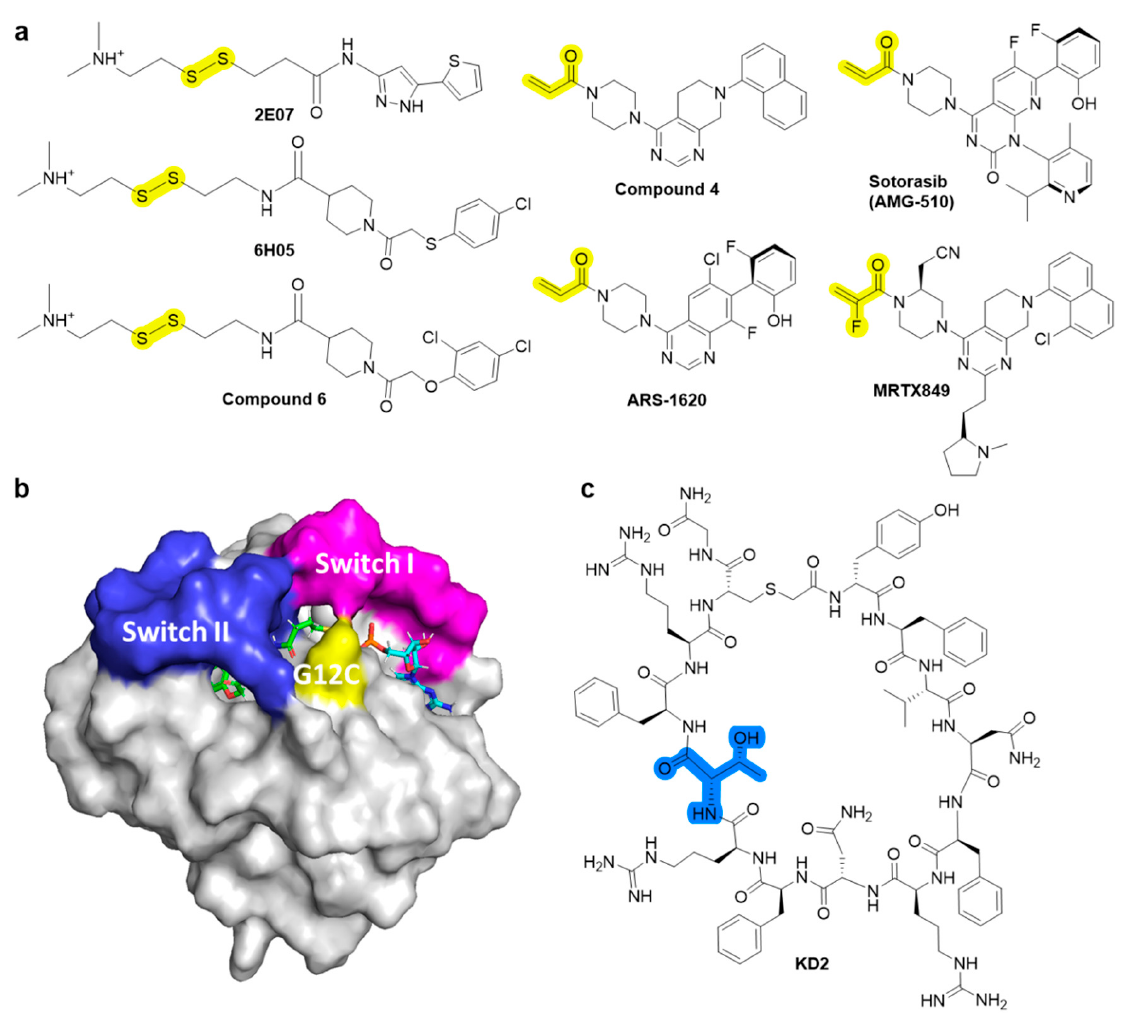
Figure 3. Chemical structures of ( a ) covalent inhibitors of KRAS G12C . The functional groups with which Cys at position 12 forms covalent bonds are highlighted in yellow. ( b ) compound 6 (green) bound in the S-IIP of KRAS G12C with GDP (cyan) (PDB 4LUC). ( c ) A cyclic peptide ligand, KD2 , of KRAS G12D shown using an integrated in vitro translation–mRNA display selection platform. The Thr residue with which Asp at position 12 of KRAS G12D interacts is highlighted in blue.